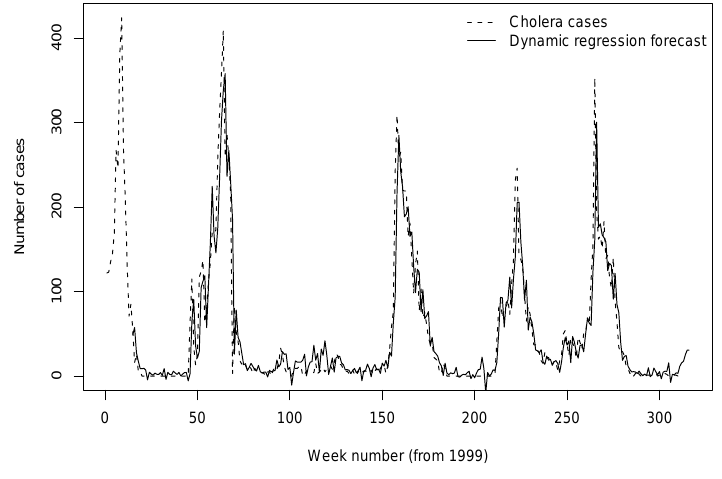
Figure 10: Model fit using dynamic regression. Note that the results from the model Exp(temperature) at lags 5,6,7 + AR(1) are